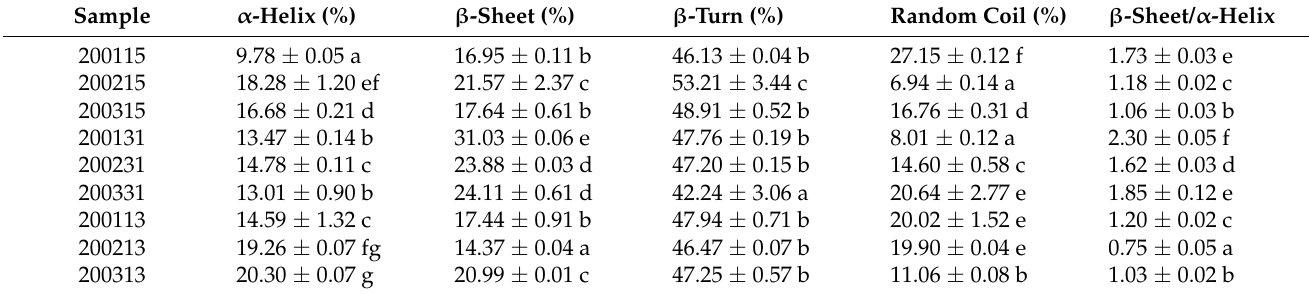
Table 3. Proportions of different protein secondary structure types in different recombinant flours.